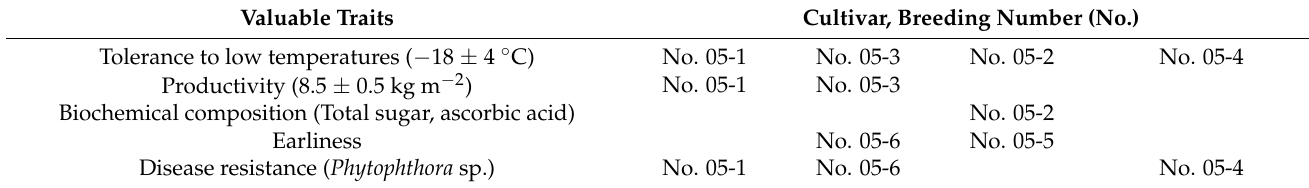
Table 5. Parental material from Jerusalem artichoke national and adapted genetic resources.